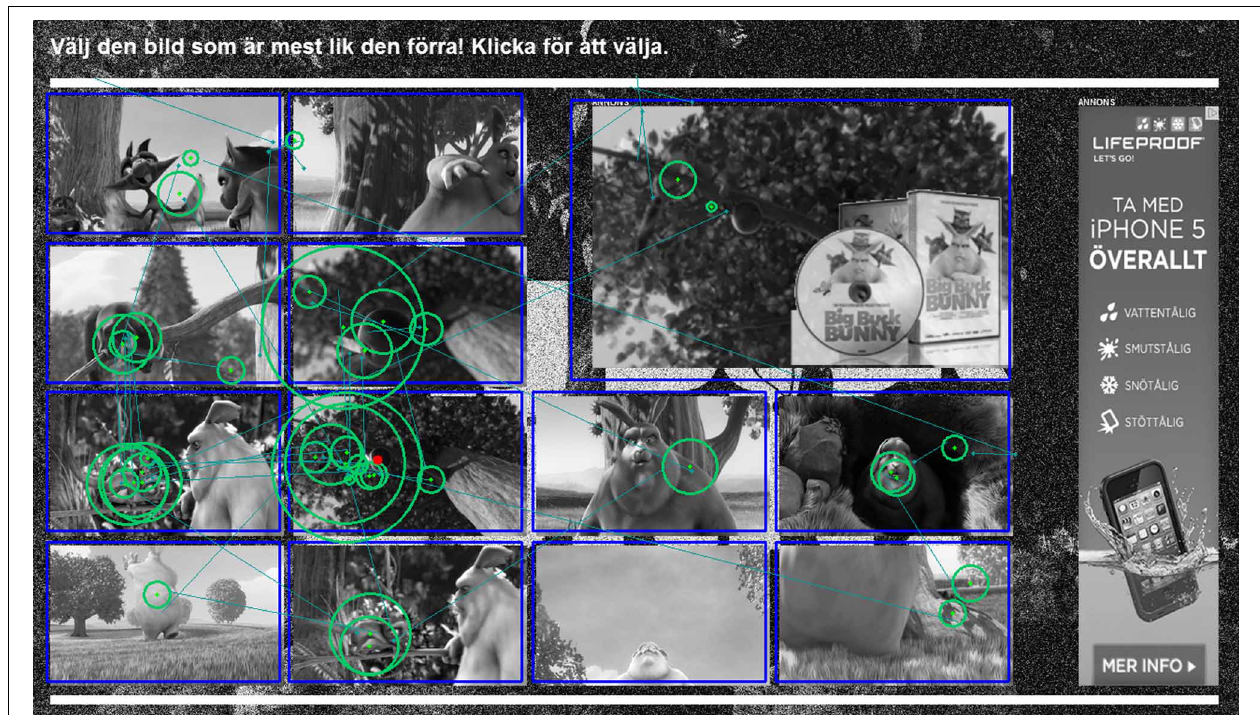
FIGURE 1 | Layout of the image selection web page used to solve the online tasks. The image array contains 3 target images and 9 distractor images in randomized positions. An experimental advert in the high task relevance condition is presented in the